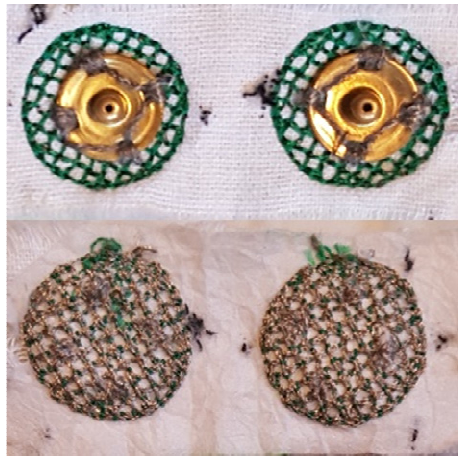
Figure 1. Example of embroidered electrodes used in this study. The outer side shows snap connect- ors ( top ), and the inner side shows conductive thread ( bottom